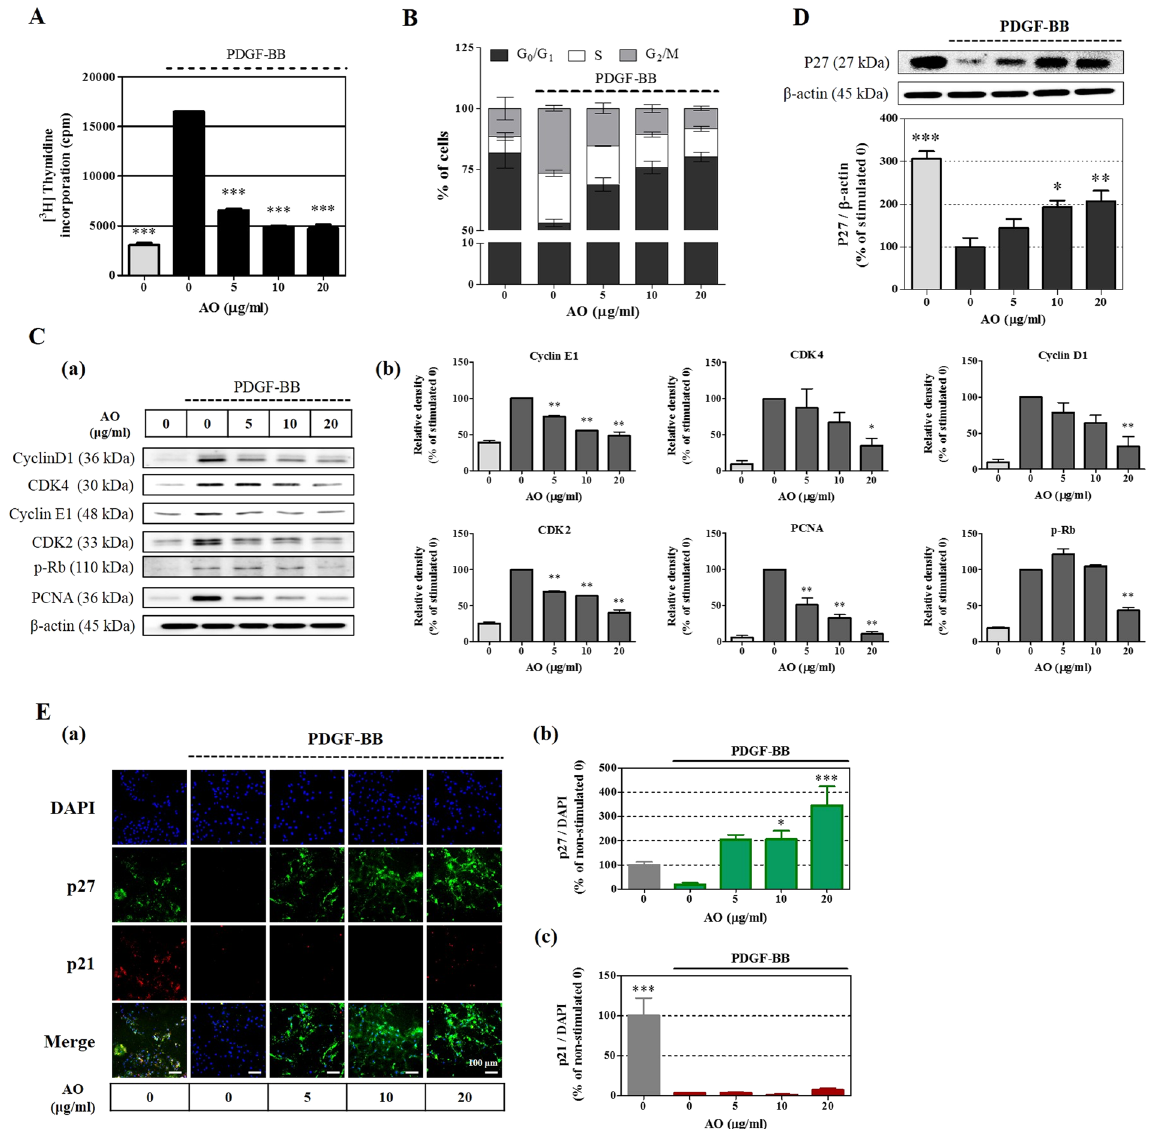
Figure 2. Effects of the AO extract on DNA synthesis and cell cycle regulatory proteins. Quiescent VSMCs cultured in serum-starved medium were stimulated with 25 ng/mL PDGF-BB, and the effects of the AO extract (5–20 μ g/mL) on DNA synthesis (n = 3) ( A ) and the cell cycle progression ( B ) (n = 3) were assessed. ( C ) The effects of the AO extract on cell cycle regulatory proteins that were stimulated by PDGF-BB, including cyclin D1/E1, CDK2/4, Rb, and PCNA as negative regulatory molecules, was measured using SDS-PAGE followed by immunoblotting (n = 3) (a), using β -actin for normalization (b). ( D ) The inhibitory effects of the AO extract on p21 WAF1/CIP1 and p27 KIP1 expression were examined using SDS-PAGE followed by immunoblotting (a), using β -actin for normalization (b,c), and the results were analyzed using densitometry. ( E ) p21 WAF1/CIP1 and p27 KIP1 expression were also examined using an immunofluorescence assay (a), using the fluorescence levels of 4 ′ ,6-diamidino-2-phenylindole (DAPI) for normalization (b), and the levels of immunofluorescence were analyzed using densitometry; the values represent percentages relative to the stimulated control. Images are presented at their original magnification (200 × , scale bar: 100 μ m). The results are an average of three similar, independent experiments and are expressed as the mean ± SEM. Significant differences relative to the PDGF- stimulated controls are indicated by asterisks: * P < 0.05, ** P < 0.01, *** P < 0.001. The full size blot is shown in Supplementary Figure